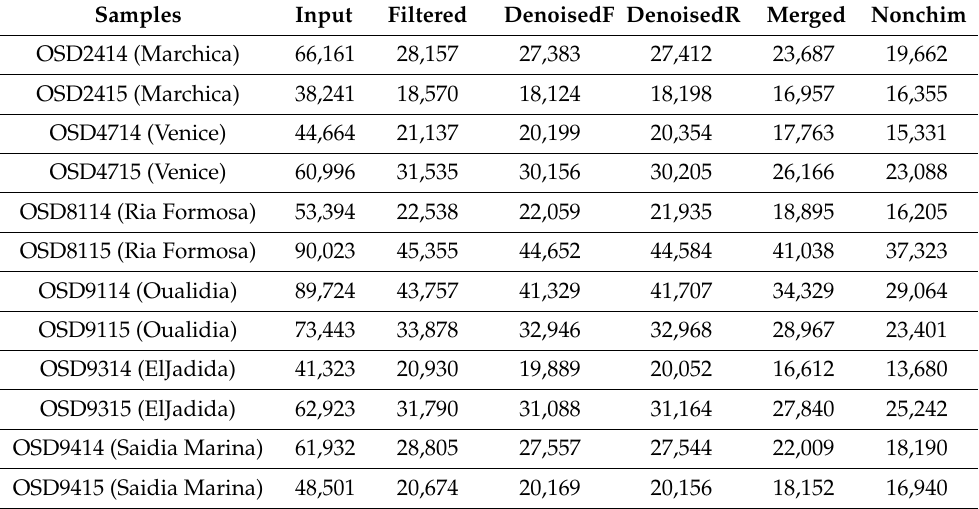
Table 3. Number of DNA sequence reads that made it through each step in the DADA2 tool